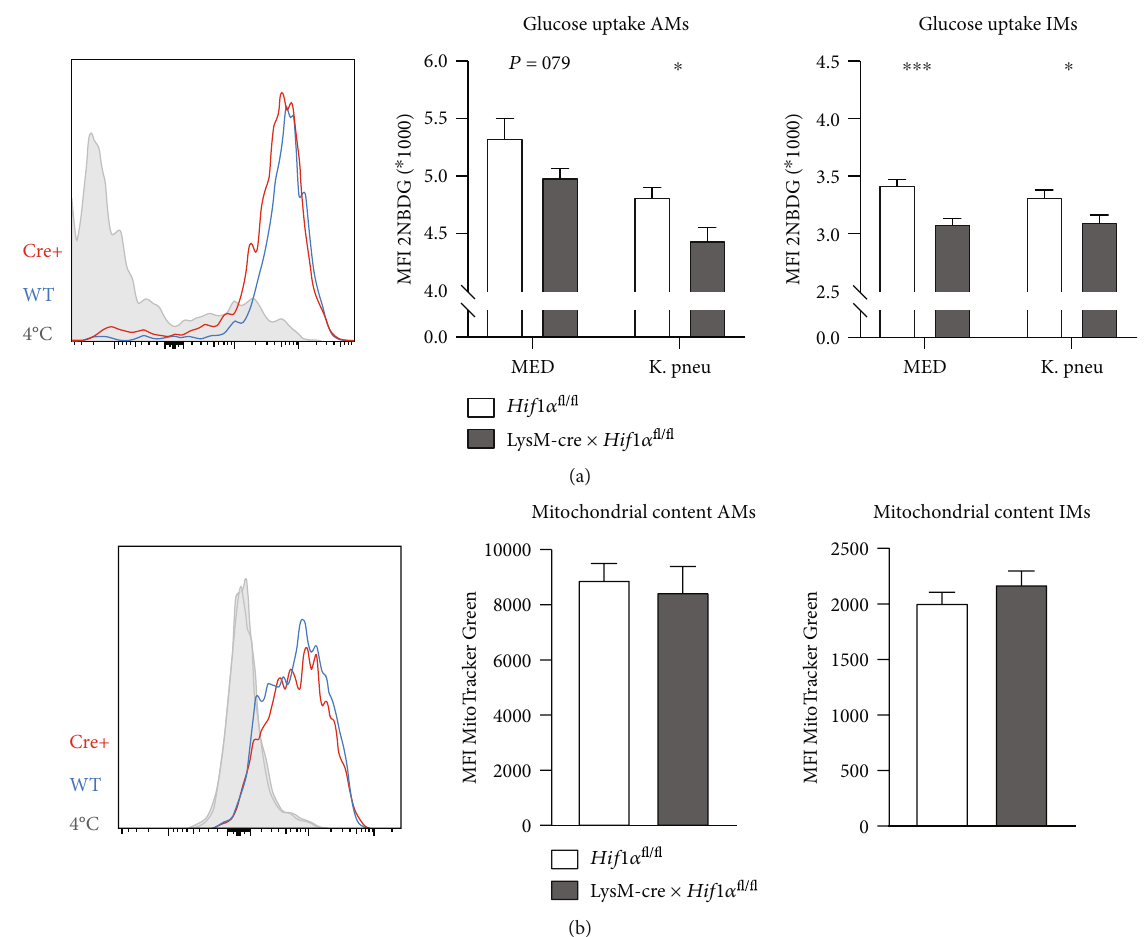
Figure 5: HIF1 α de fi ciency a ff ects glucose metabolism but not mitochondrial mass of AMs and IMs. Glucose uptake after 2.5 hours of stimulation with heat-killed K. pneumoniae (K. pneu) or medium control (MED), as measured by the MFI of 2NBDG, of AMs and IMs within lung suspensions of LysM-cre × Hif1 α fl / fl mice and littermate controls (a). Mitochondrial mass as measured by the MFI of the MitoTracker Green probe in AMs and IMs of LysM-cre × Hif1 α fl / fl mice and littermate control after 3 hours of incubation in medium (b). As a negative control, lung suspensions were kept at 4 ° C. Data are shown as bar graphs showing mean with standard error of the mean of 10 mice per group for the glucose uptake assay and 6 mice per group for the mitochondrial mass. Groups were compared using Student ’ s t -tests with the Holm-Sidak multiple comparison test where appropriate. ∗ P < 0 : 05 ; ∗∗ P < 0 : 01 ; ∗∗∗ P < 0 : 001